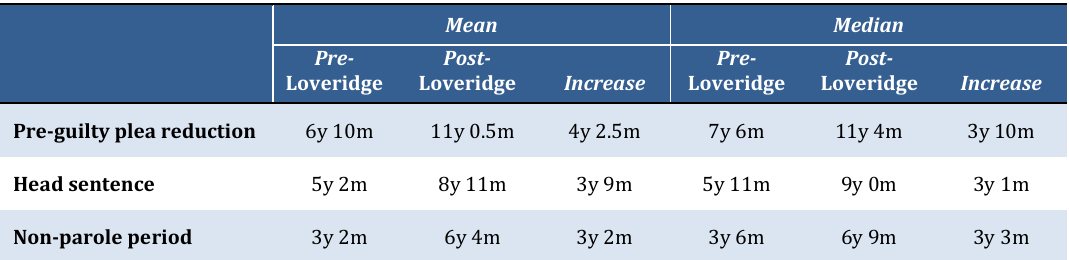
Table 2: Comparison of mean and median sentences pre ‐ and post ‐ Loveridge Mean Median Pre ‐ Post ‐ Pre ‐ Post ‐ Loveridge Loveridge Increase Loveridge Loveridge Increase Pre ‐ guilty plea reduction 6y 10m 11y 0.5m 4y 2.5m 7y 6m 11y 4m 3y